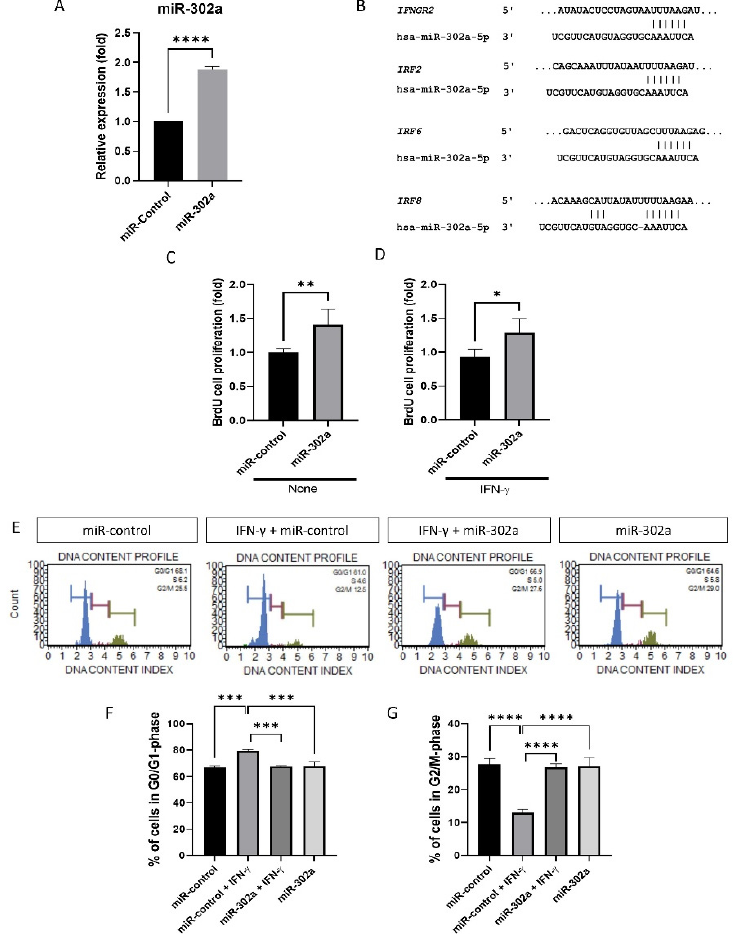
Figure 1. Effect of miR-302a on cell proliferation. ( A ) Expression of miR-302a was elevated. ( B ) Predicted miR-302a–binding sites in the 3 (cid:48) -UTR of the IFNGR2 , IRF2 , IRF6, and IRF8 mRNA indicate the interaction between hsa-miR-302a and IFN- γ signaling pathway. Perfect matches in seed regions are indicated by lines. miRNA targets were predicted using miRBase and Targetscan- Human 8.0. ( C , D ) BrdU incorporation assay was performed in miR-control and miR-302a with or without interferon- γ (IFN- γ ). ( E ) Cell cycle analysis was performed, and cell cycle graph was shown. ( F , G ) IFN- γ induced the cell cycle arrest, which was eliminated by miR-302a. * p < 0.05, ** p < 0.01, *** p < 0.001 and **** p <